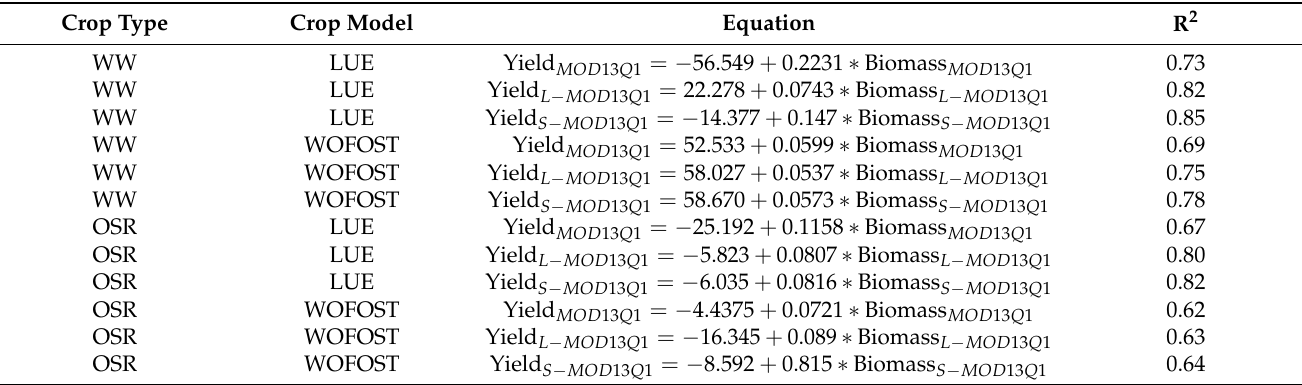
Table A1. Summary of linear regression equations used to calculate crop yield from biomass obtained from different satellite products (MOD13Q1, Landsat (L)-MOD13Q1, and Sentinel-2 (S)-MOD13Q1) for WW and OSR using LUE and WOFOST models. The yield obtained is in